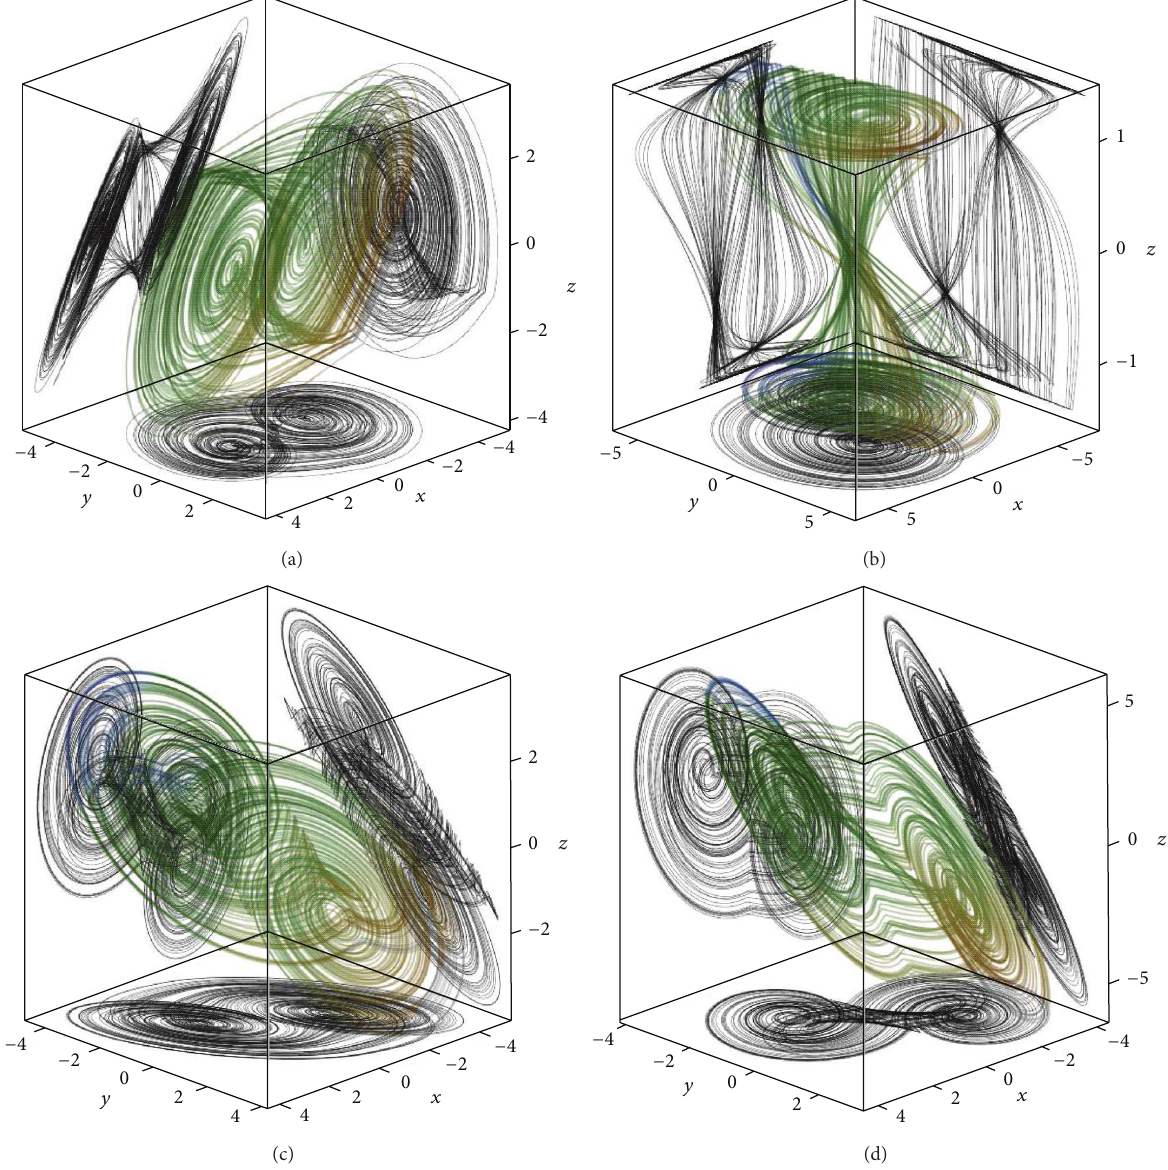
Figure 1: System configuration 𝐴 in normal form (a), Jordan form (b), and first and second equivalent.